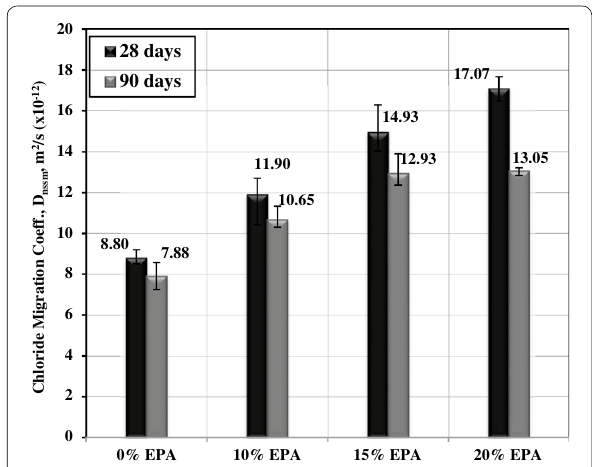
Fig. 12 Chloride migration coefficient of concrete prepared with varying EPA content.